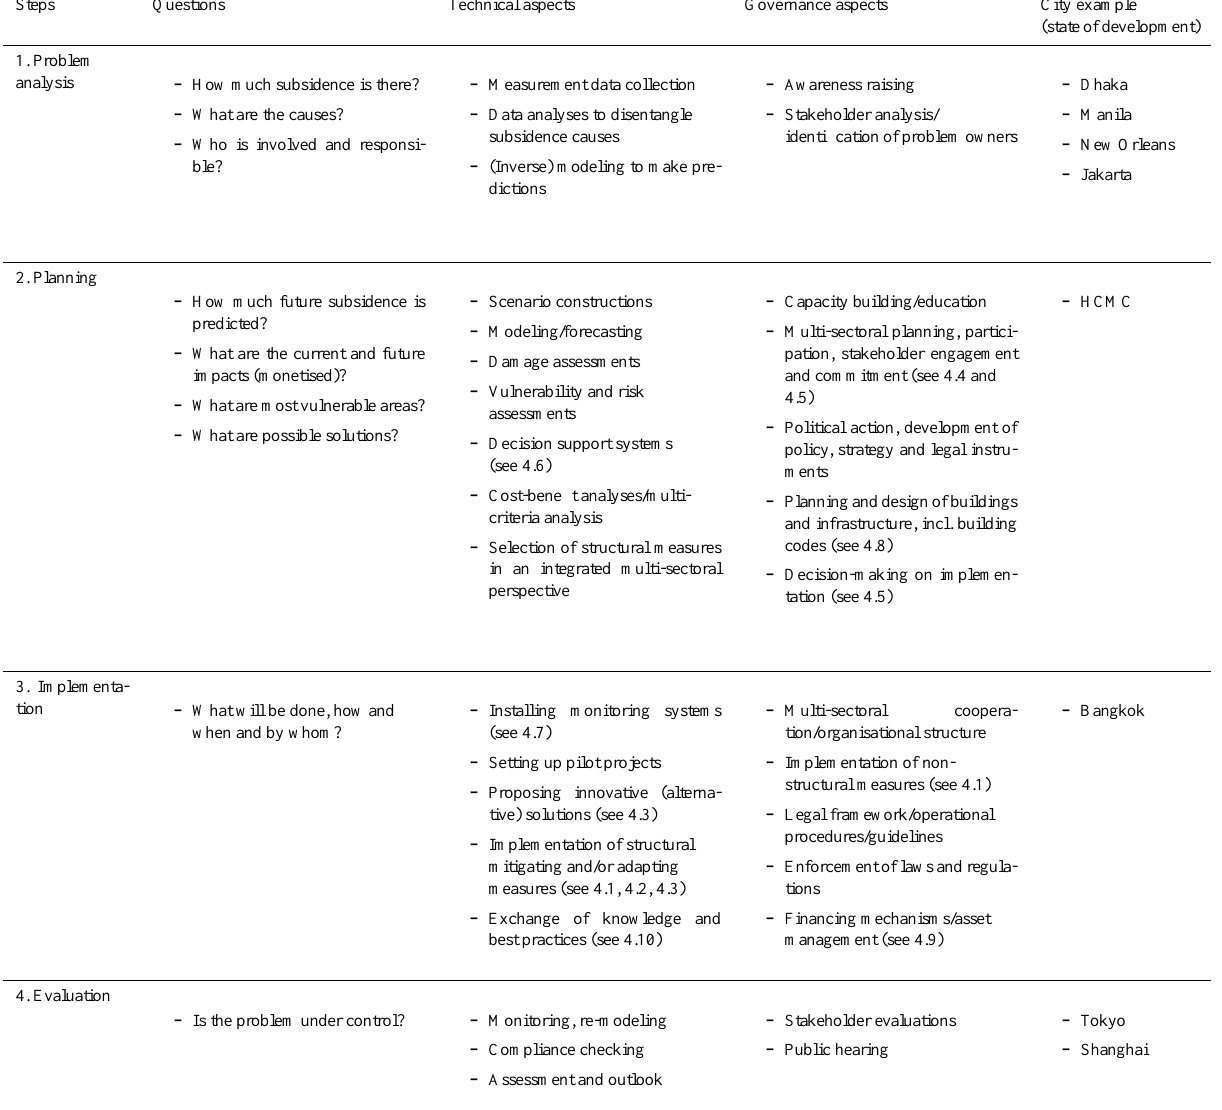
Table 1. The main steps and elements of the Integrated Assessment Framework for